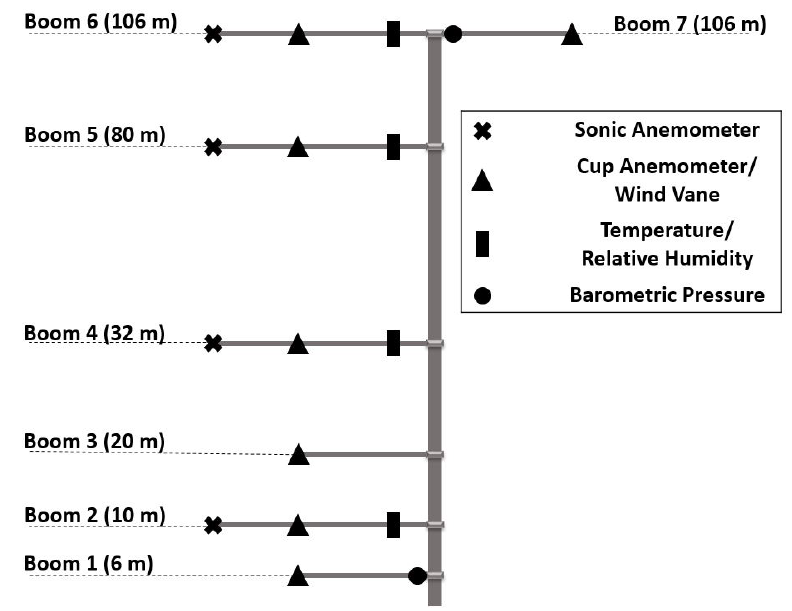
Figure 4. Mounting position of instruments and boom levels on the met tower. Booms 1–6 extend towards the west while boom 7 extends towards the